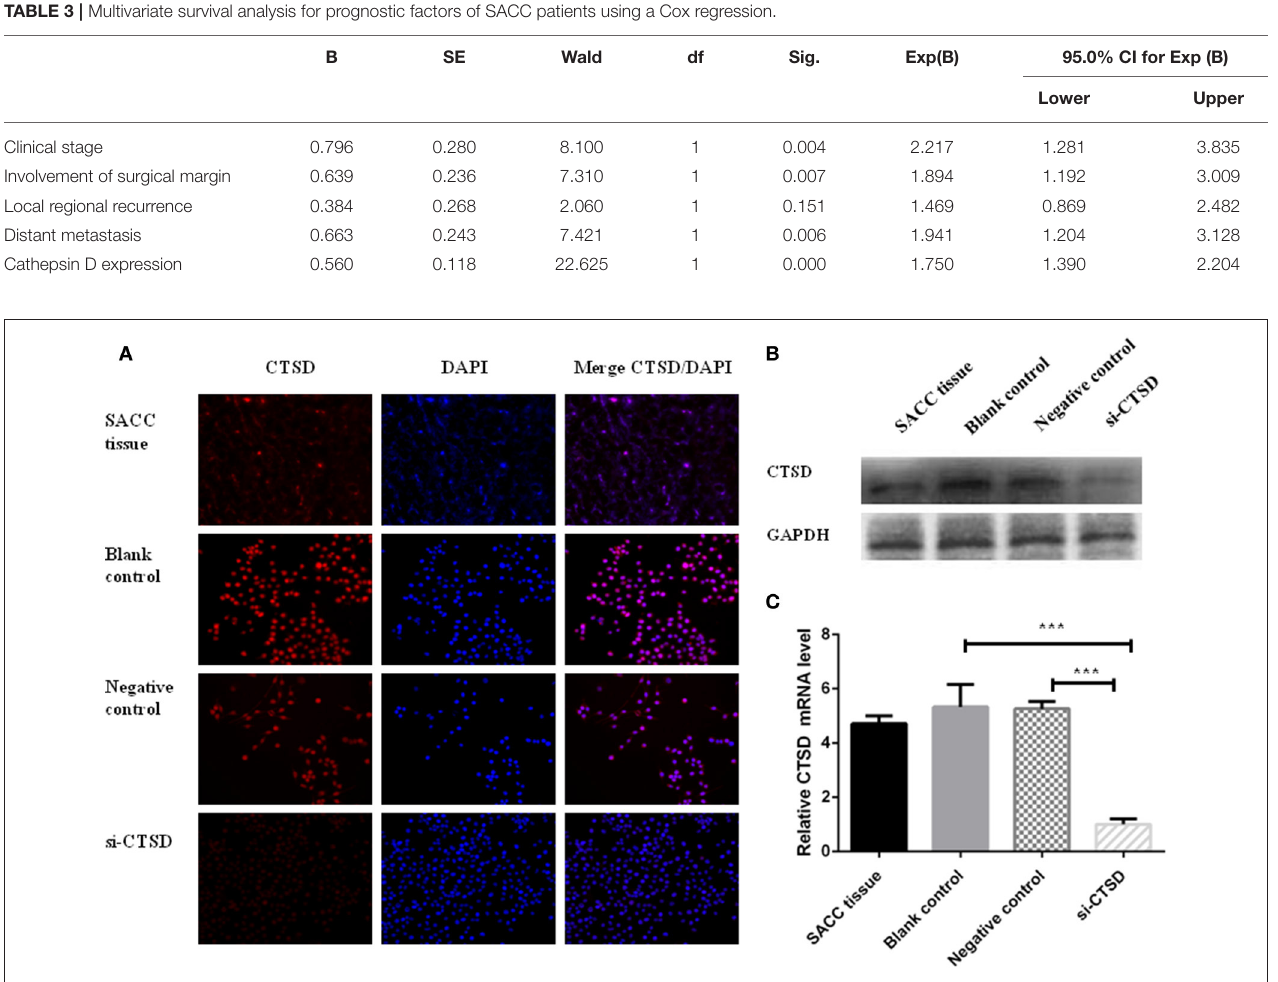
FIGURE 3 | Expression of CTSD in SACC tissues and SACC-LM cells. (A) immunofluorescence analysis of CTSD expression in SACC tissue and transfection efficiency of siRNA mediated CTSD knockdown in SACC-LM cells (blank control, negative control, and si-CTSD group), (200 × ). ( B ) Western blot analyses of CTSD expression in SACC tissue and transfection efficiency of siRNA mediated CTSD knockdown in SACC-LM cells (blank control, negative control, and si-CTSD group). ( C) qRT-PCR analyses of CTSD expression in SACC tissue and transfection efficiency of siRNA mediated CTSD knockdown in SACC-LM cells (blank control, negative control, and si-CTSD group), (*** p <